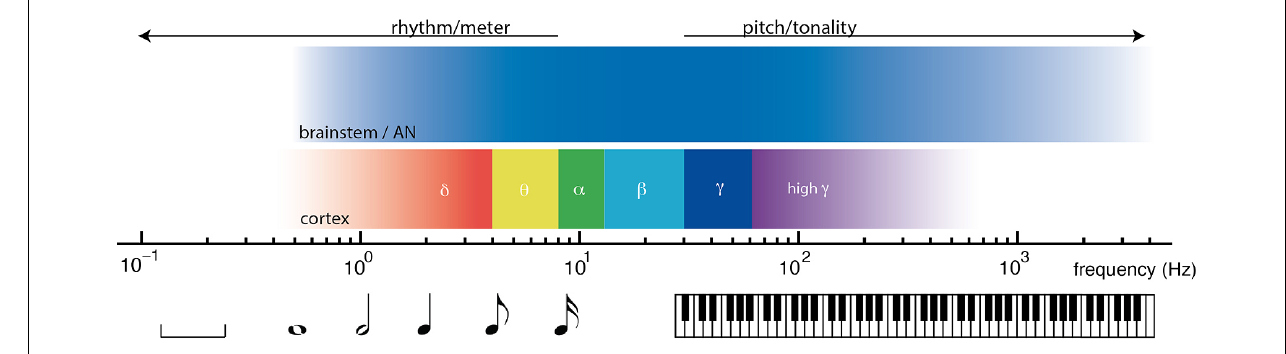
FIGURE 2 |Timescales of neural dynamics and timescales of musical communication. Music engages the brain on multiple timescales, from fractions of one cycle per second (left) to thousands of cycles per second